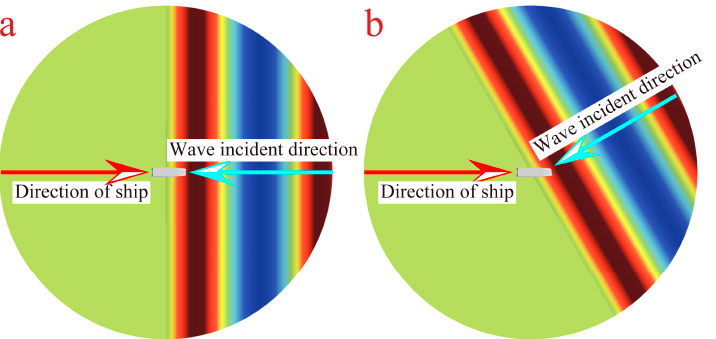
Figure 8. Sailing direction and wave direction of the USV: ( a ) 0° wave direction angle, ( b ) 30° wave direction angle.